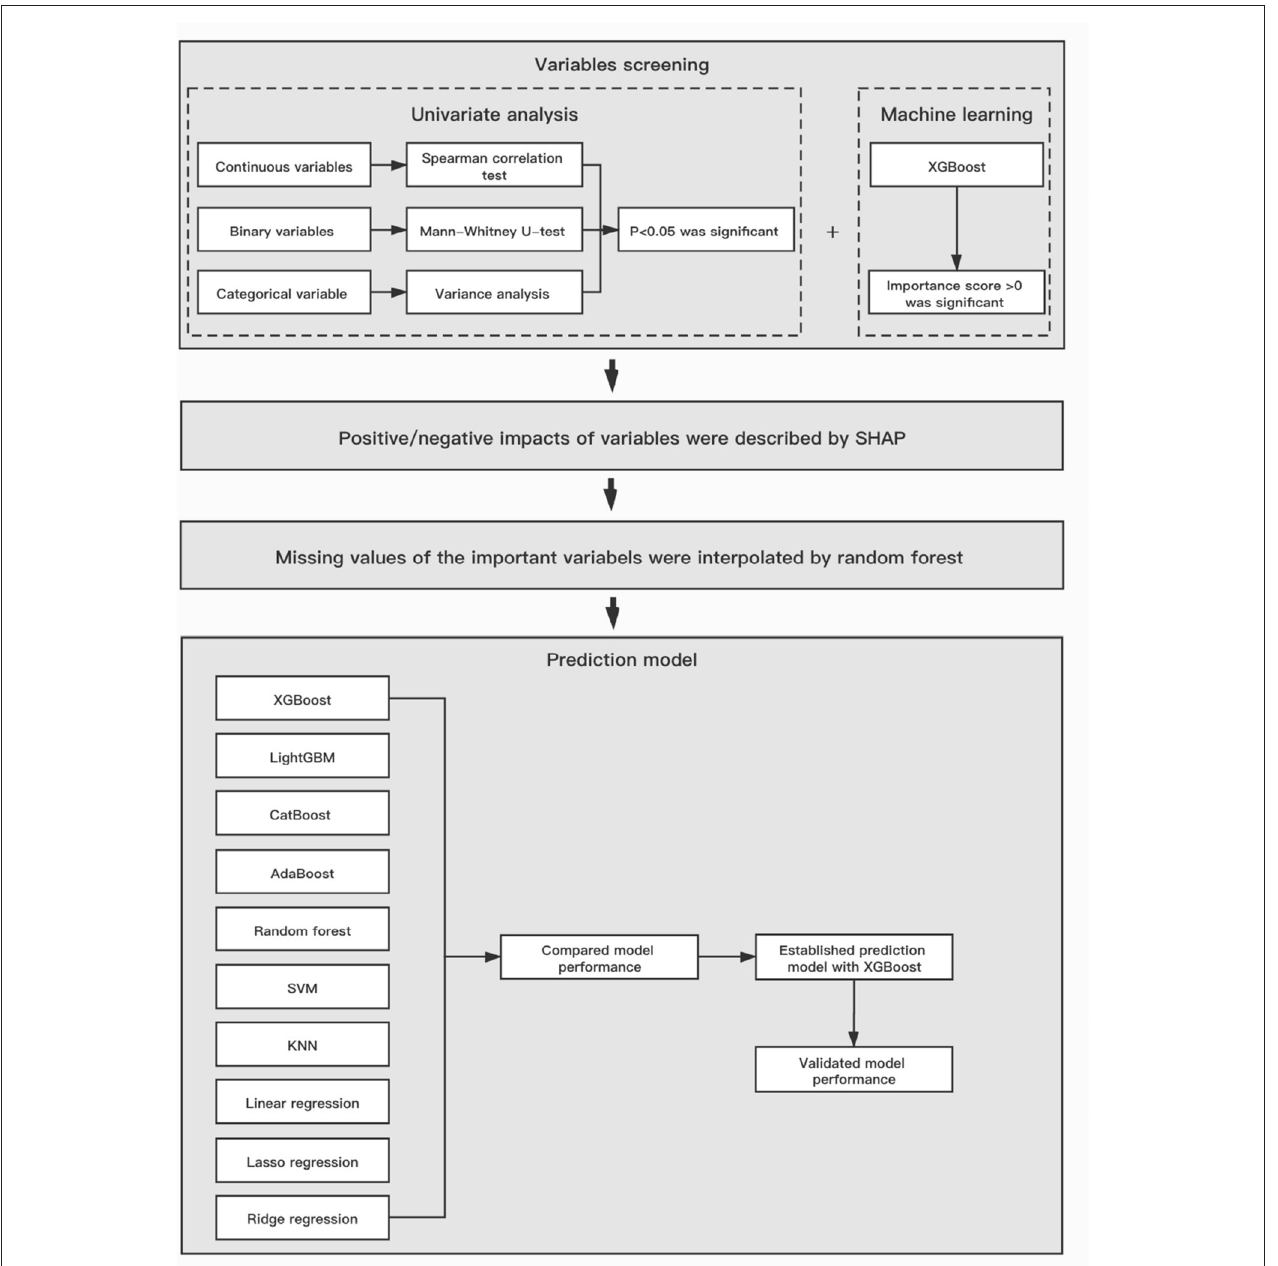
FIGURE 1 | The workflow of data analysis and model establishment. XGBoost, Extreme Gradient Boosting; SVM, support vector machine; KNN, k-Nearest